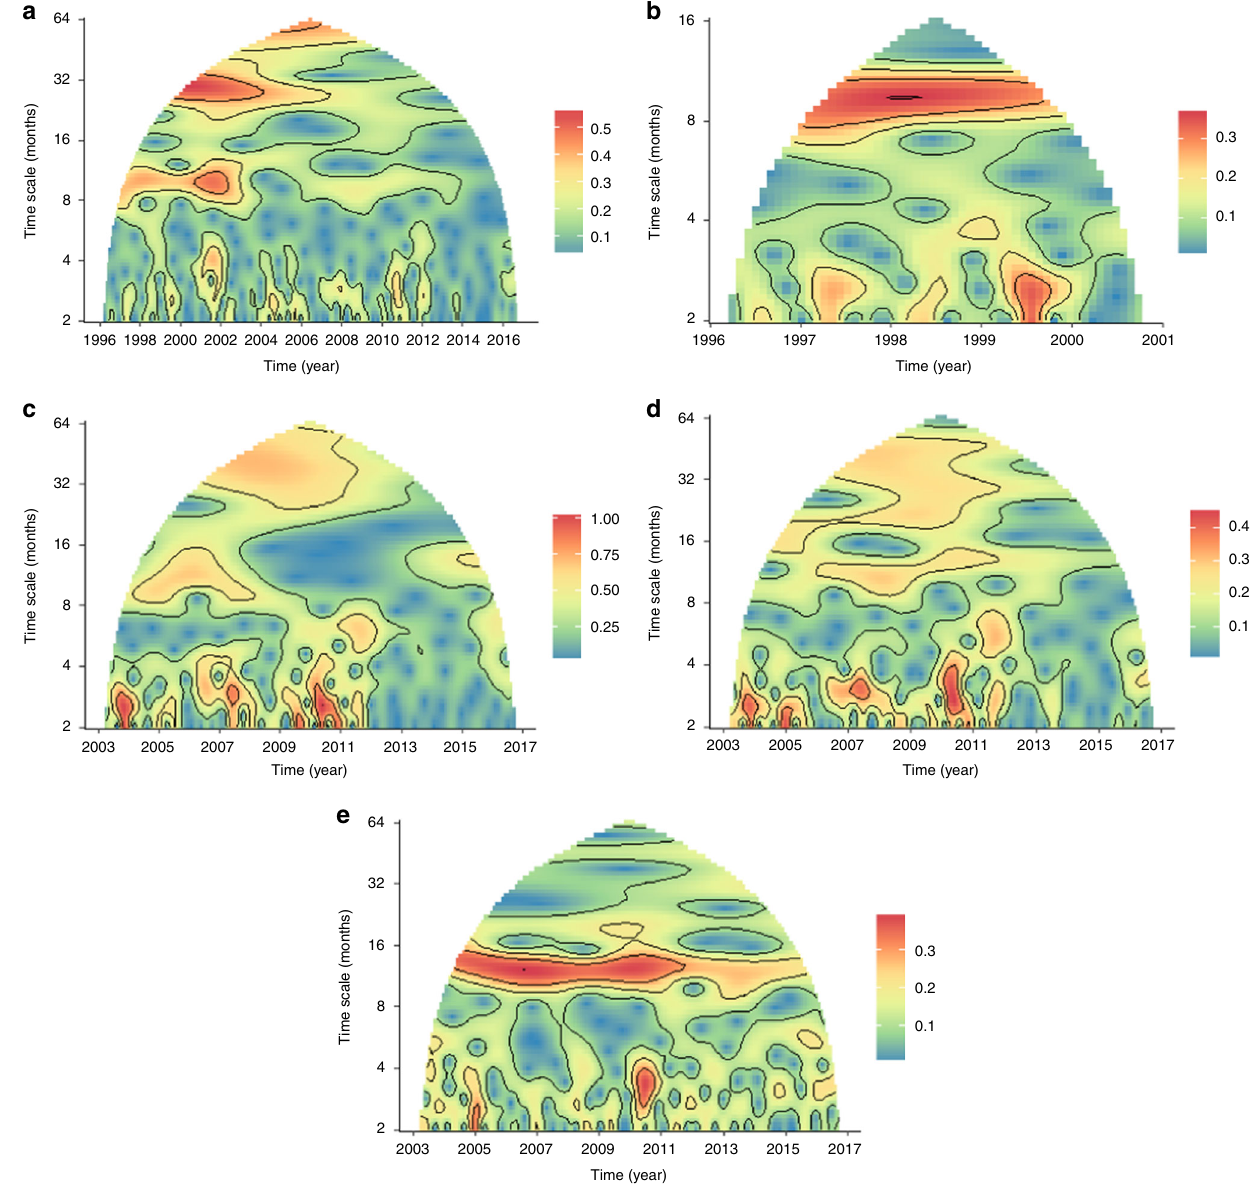
Fig. 2 Mean Field Wavelet analysis of NHI/TTH time series from January 1996 to August 2016. The vertical axis indicates periods (cycles) while the horizontal time. The brown contours correspond to four equal classes as derived from the legend a GB for the whole period, b GB before interruption, c GB after interruption, d High-risk areas after interruption, e Low-risk areas after interruption. For a wavelet energy of the mean time series analysis, see Supplementary Fig.